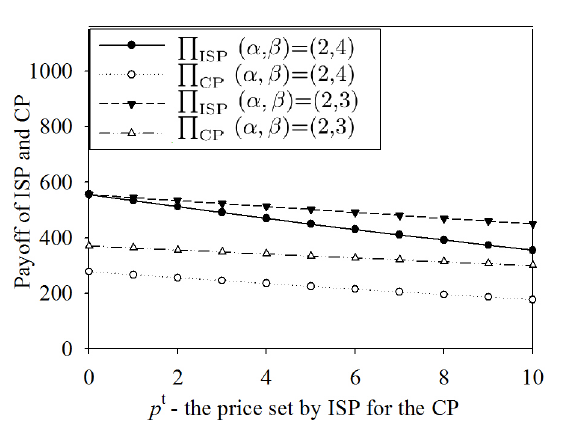
Figure 6: Payoff of ISP and